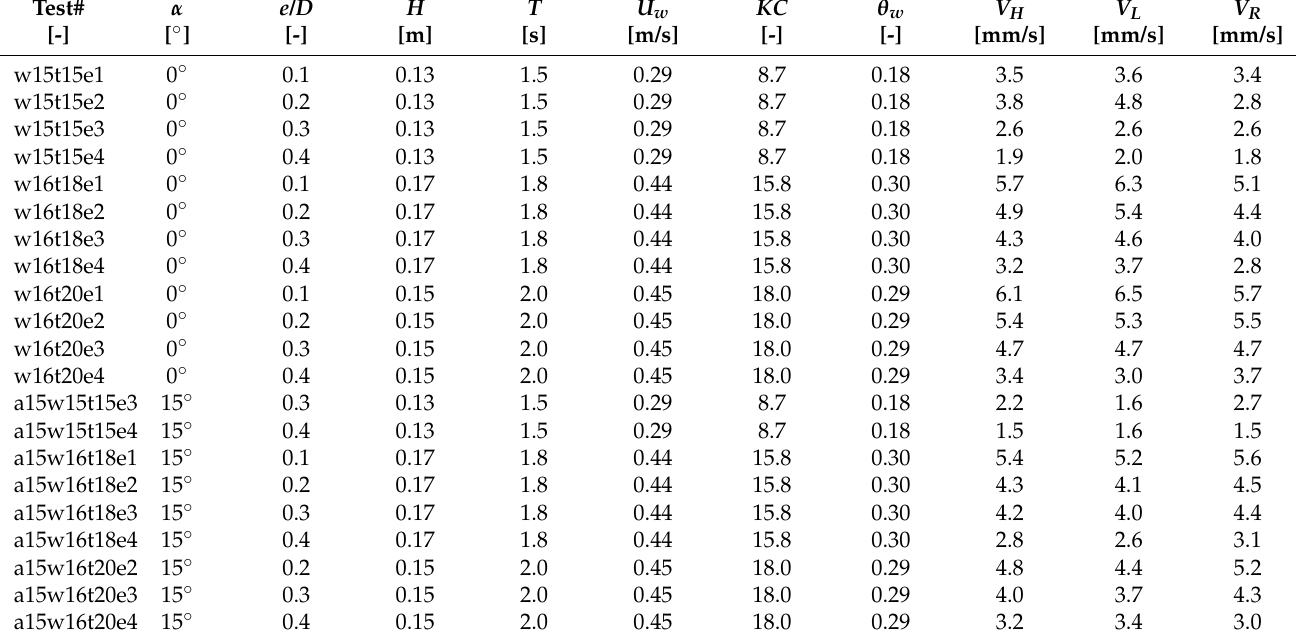
Table A1. Tests of [9]: main characteristics and results under wave-only conditions.